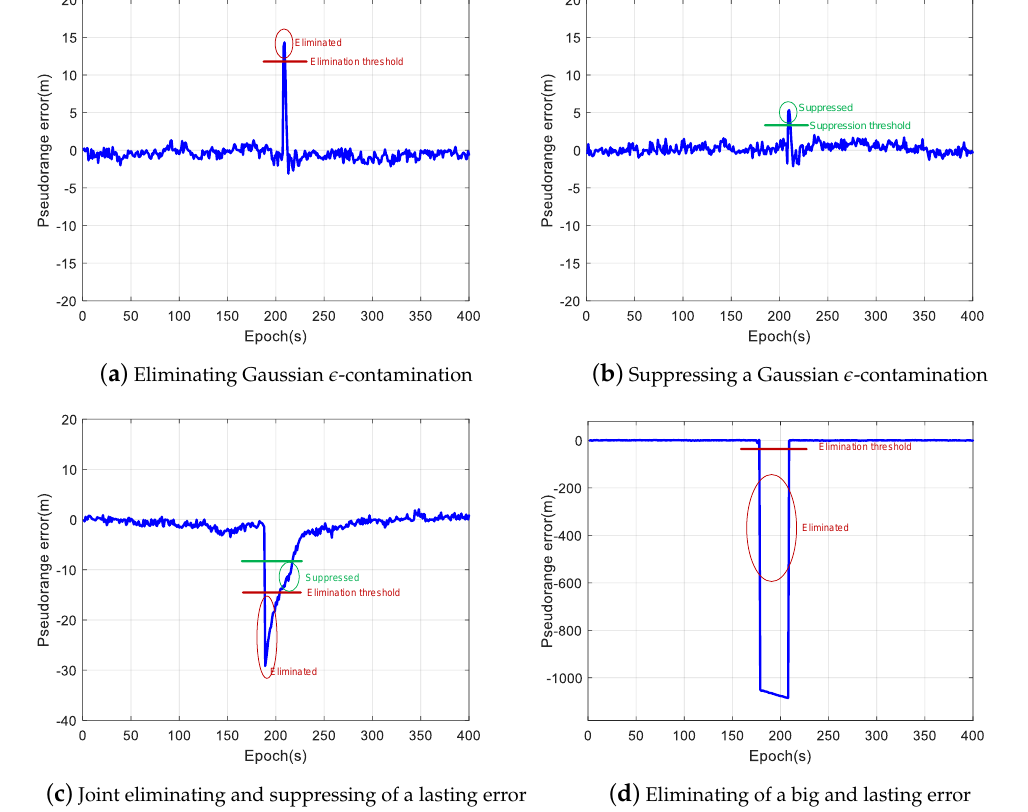
Figure 7. An illustration of the outliers processing of the proposed